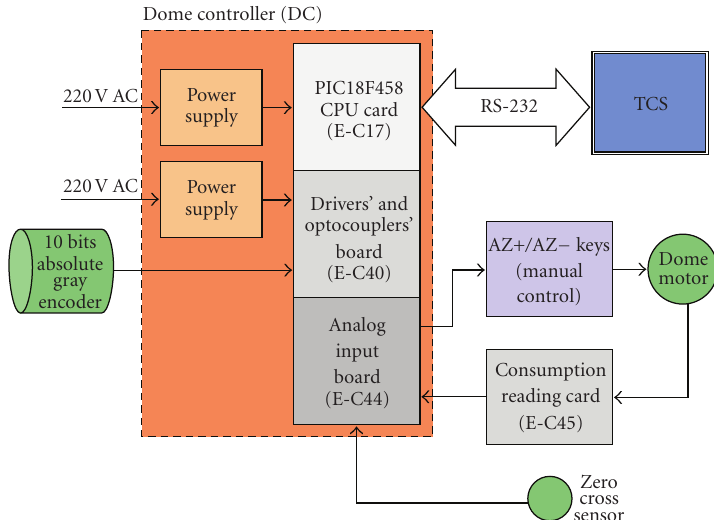
Figure 4: Connections among the di ff erent elements used in the dome control.